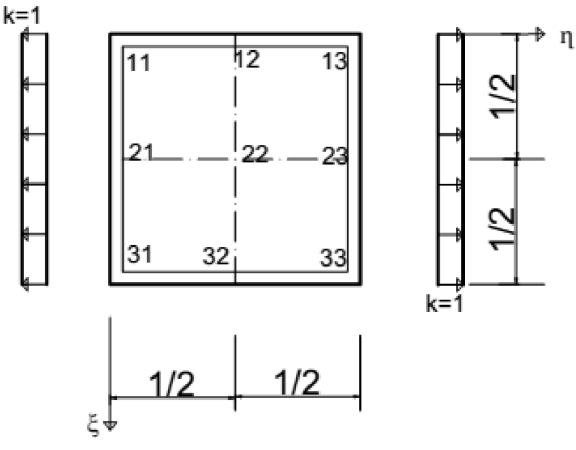
Figure 6: Square plate under elastic